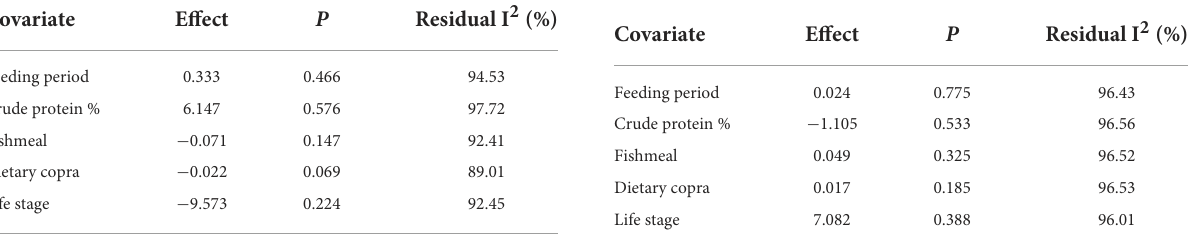
TABLE 3 Meta-regression for weight gain.